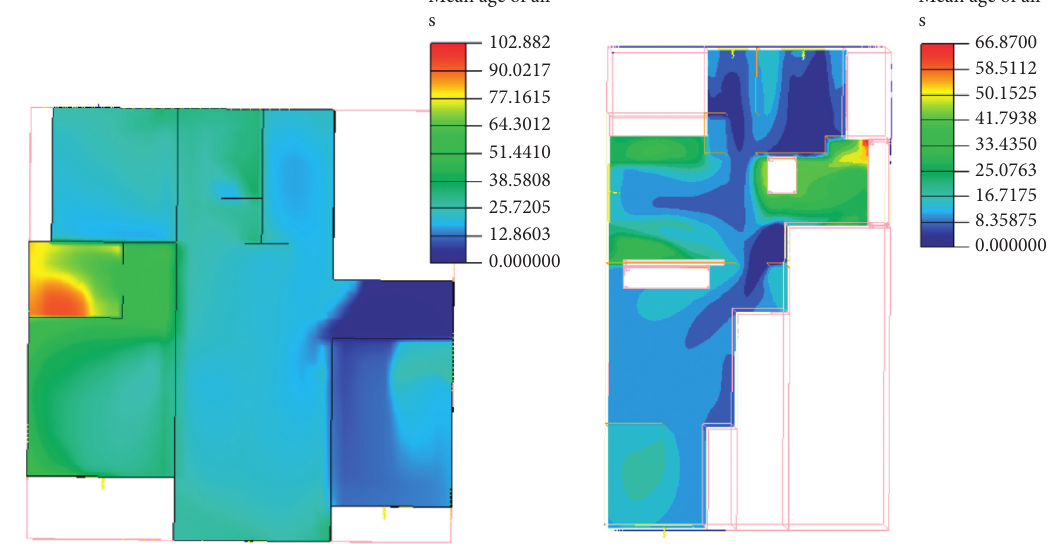
Figure 8: Air age distribution of two house types A and B under condition 1.